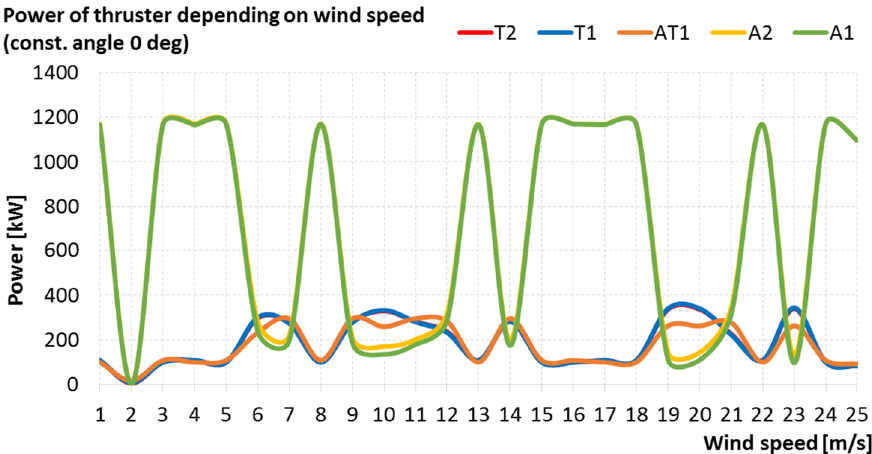
Figure 7. The power of individual thrusters depending on the wind speed (0 deg. angle).